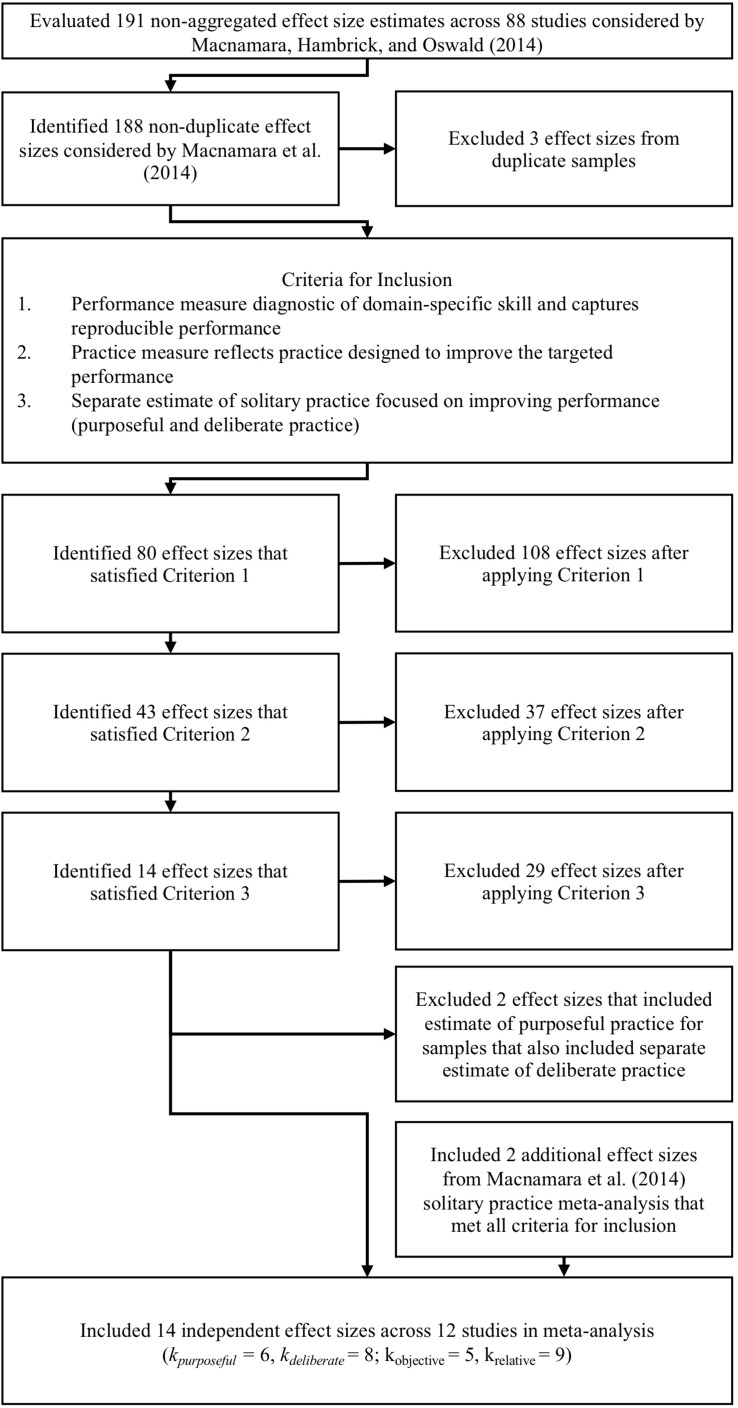
Flow diagram of applying revised inclusionary criteria to estimates of the effects of deliberate practice on performance considered by Macnamara et al. (2014).